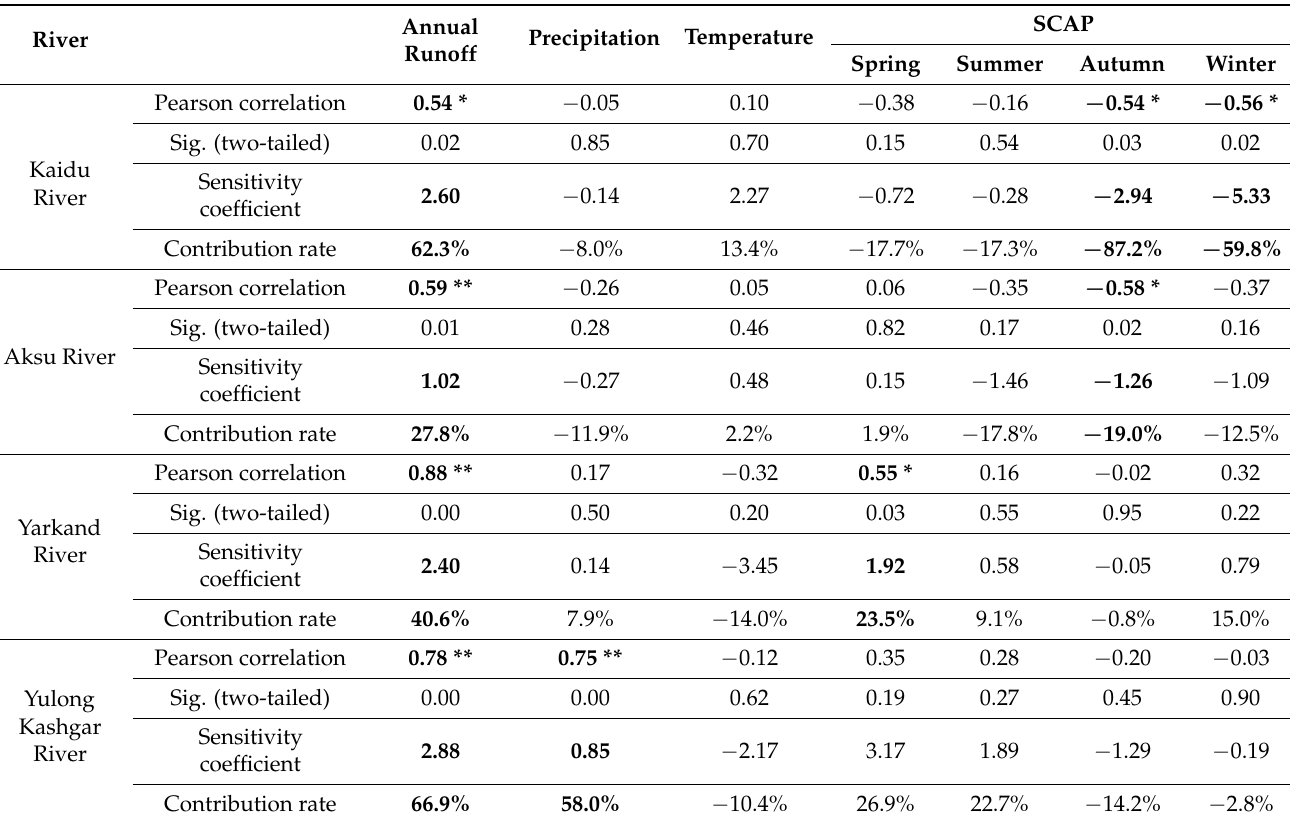
Table 4. Relationship between ASD and relative